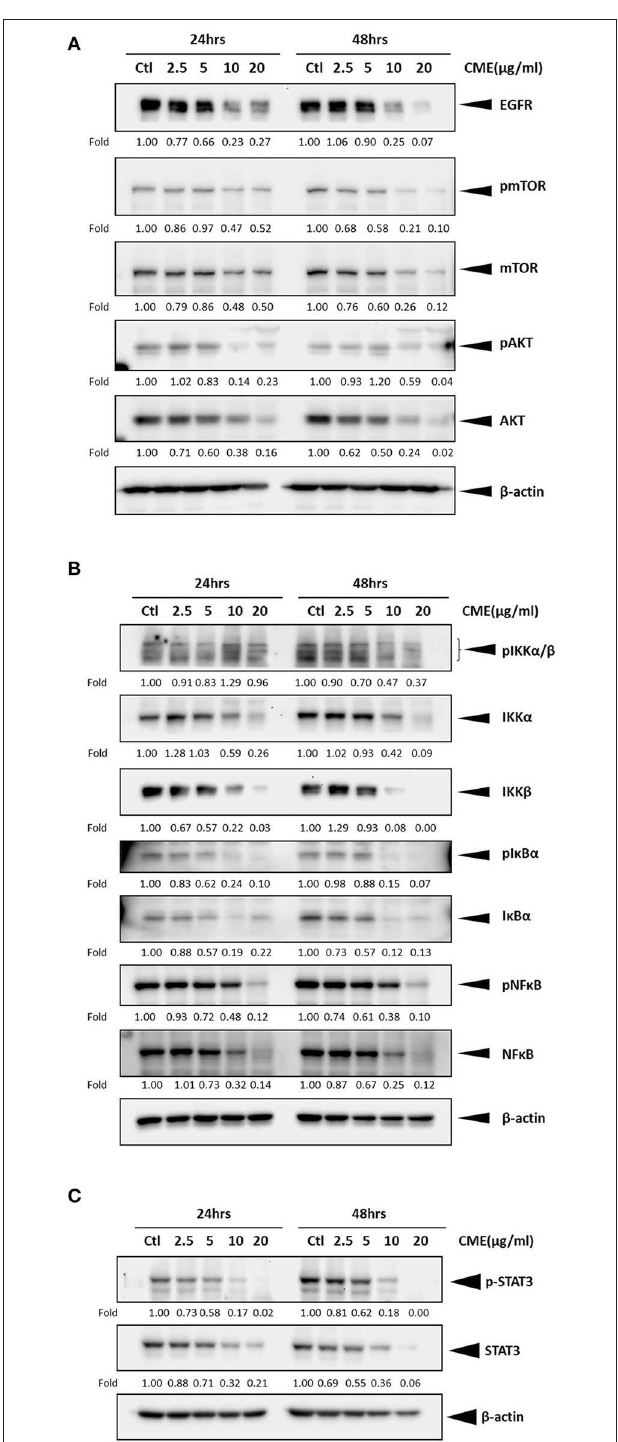
FIGURE 5 | CME suppressed NF- κ B, STAT3, and PI3K/AKT/mTOR signaling in MDA-MB-231 cells. MDA-MB-231 cells were treated with CME at the indicated concentrations for 24 or 48h. Cell pellets were collected for Western blot analysis. The expression of key proteins in the (A) PI3K/AKT/mTOR, (B) NF- κ B, and (C) STAT3 signaling pathways. β -Actin was probed as a loading control. Protein expression is indicated, as fold of control. Three independent experiments were conducted and representative blots are